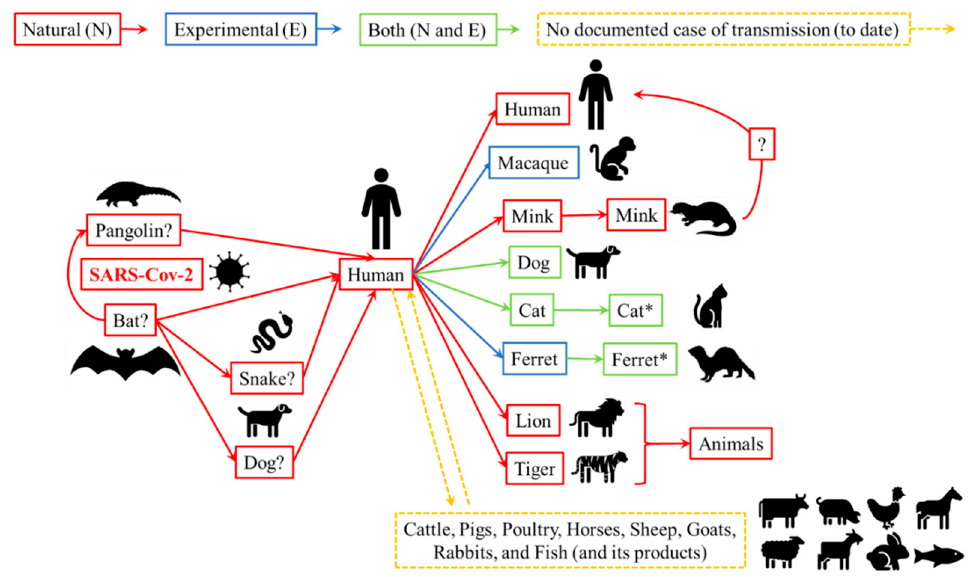
Figure 1. The human–animal transmission route and host range of SARS-CoV-2 occurred naturally and/or experimentally: suggested (not confirmed source and/or route); *animals kept together with experimentally infected ones. Adapted from Houssain et al. [5], Newman et al. [46], and OIE [56].